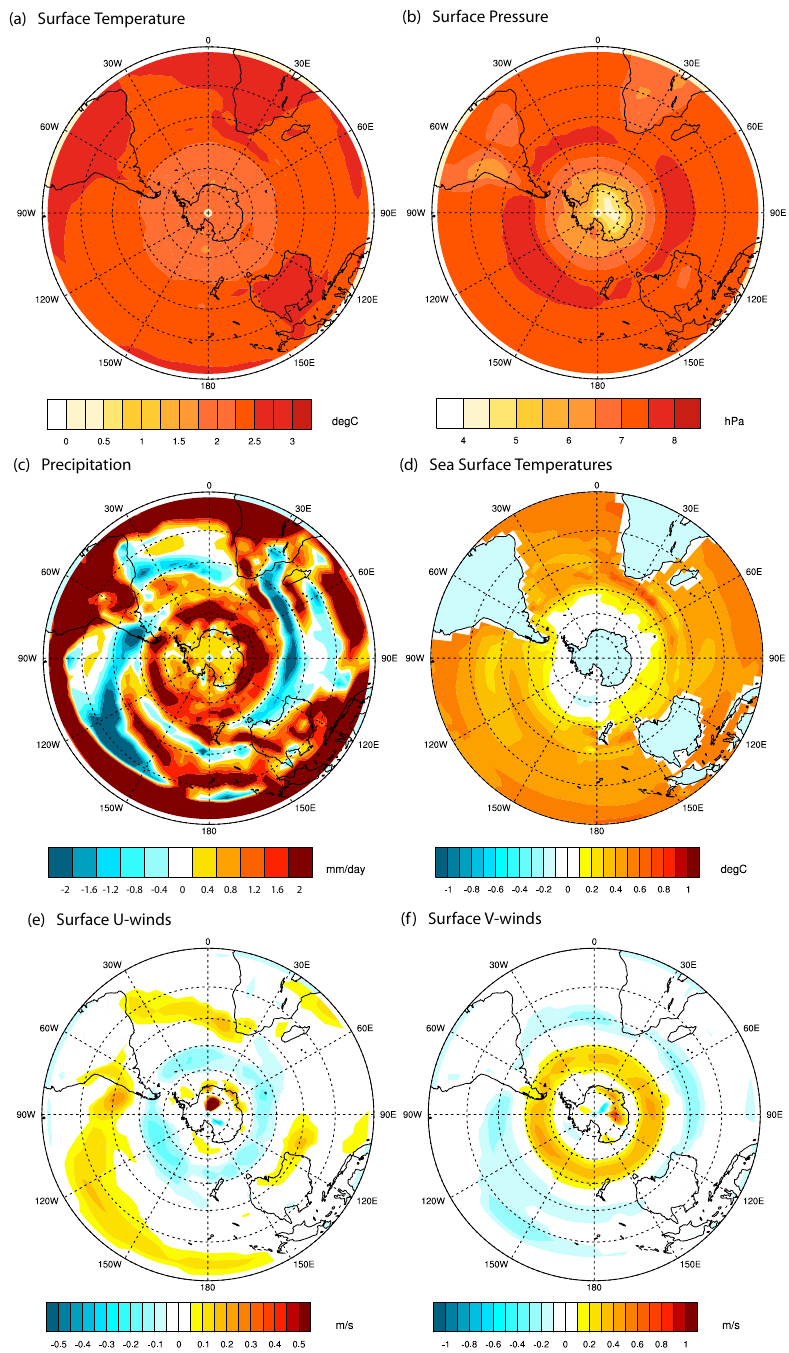
Fig. 9. Regression coefficients of summed GHG and solar forcing and (a) surface temperature, (b) surface pressure, (c) precipitation, (d) sea surface temperature, (e) zonal surface winds (denoted as U -winds) and (f) meridional surface winds (denoted as V -winds) after the impact of the volcanic eruptions was removed. For (c) to (f) only values significant at the 5% level are shaded.